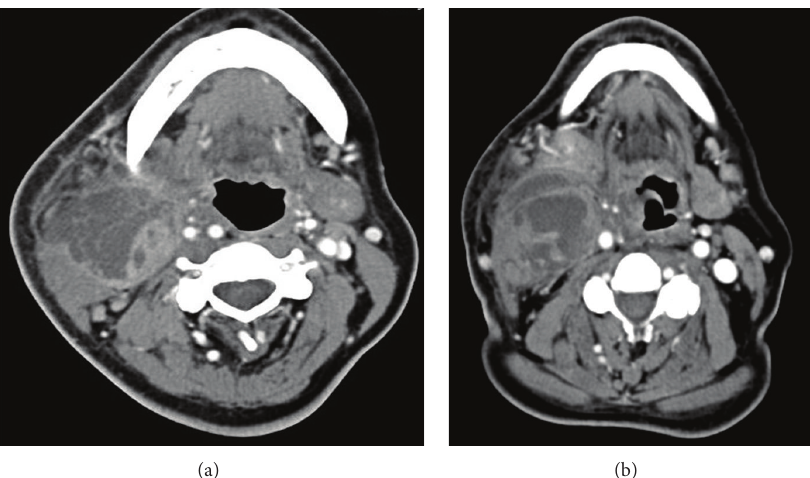
Figure 1: Neck mass imaging. (a) Computed tomography appearance in Case 1 of the multiloculated abscess involving the right sternocleidomastoidmuscle.(b)ComputedtomographyappearanceinCase2ofthemultiloculatedabscessinvolvingtherightparapharyngeal space. Both patients required surgical drainage for pathogen identification and treatment.